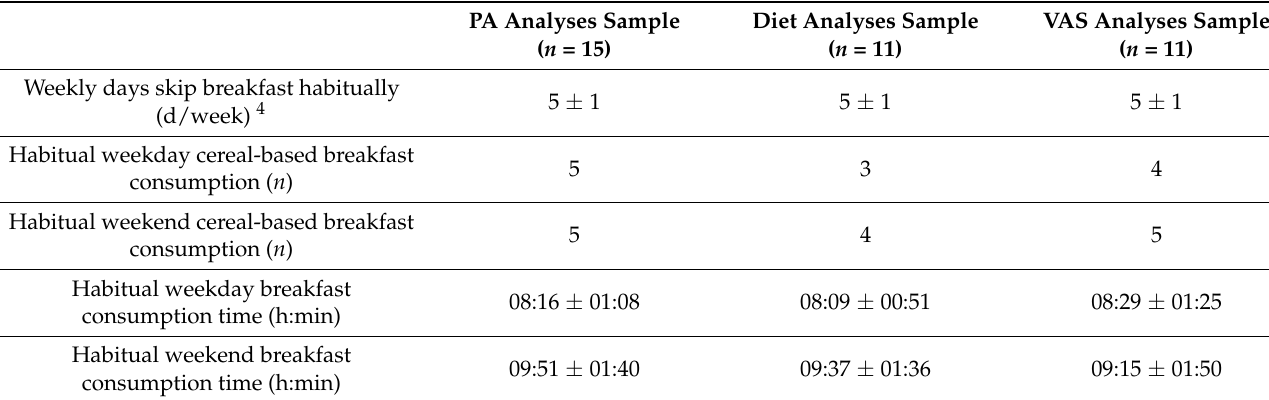
Table 1. Cont. PA Analyses Sample